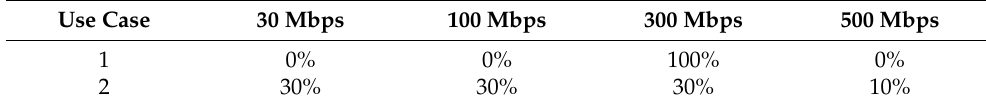
Table 4. Considered throughput requirements of the network